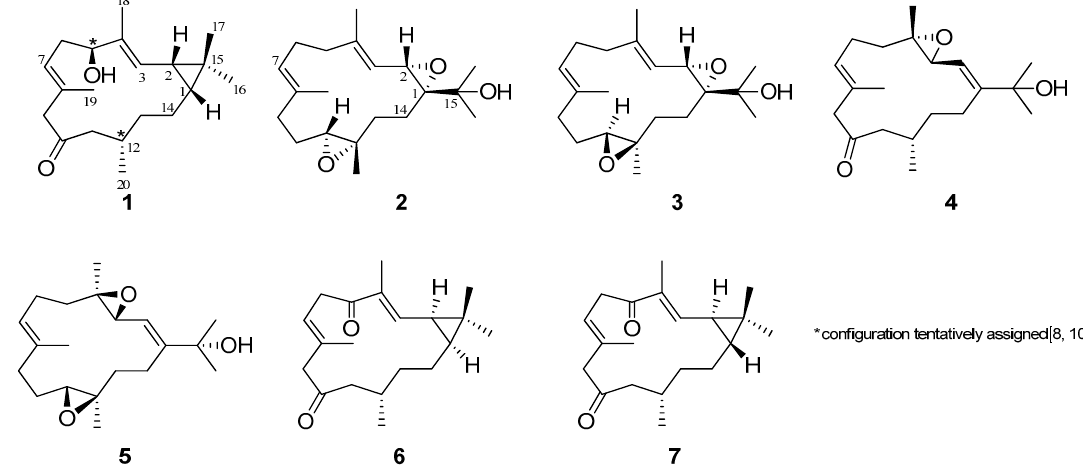
Figure 1. Chemical structures of compounds 1 – 7 .